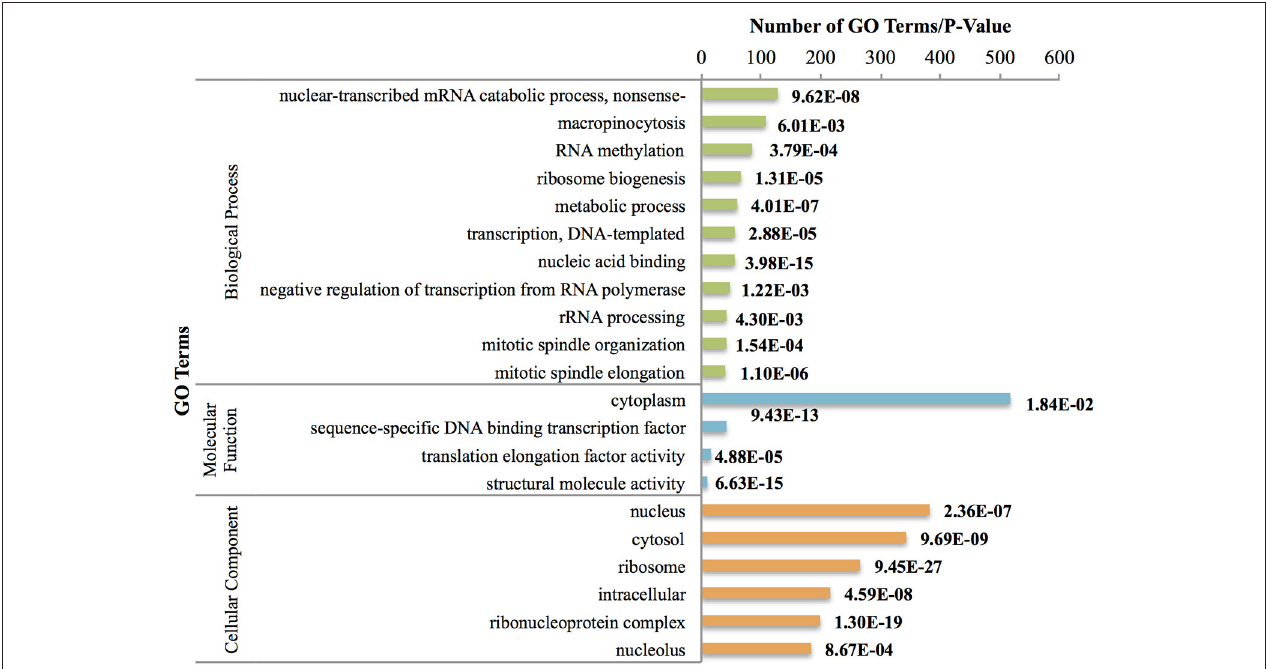
FIGURE 2 | Most frequent up-regulated GO terms between Nauplius II and Nauplius VI. P -values are indicated on the right side. GO terms have been chosen based on hyper geometric test ( P < 0.01) and most frequent